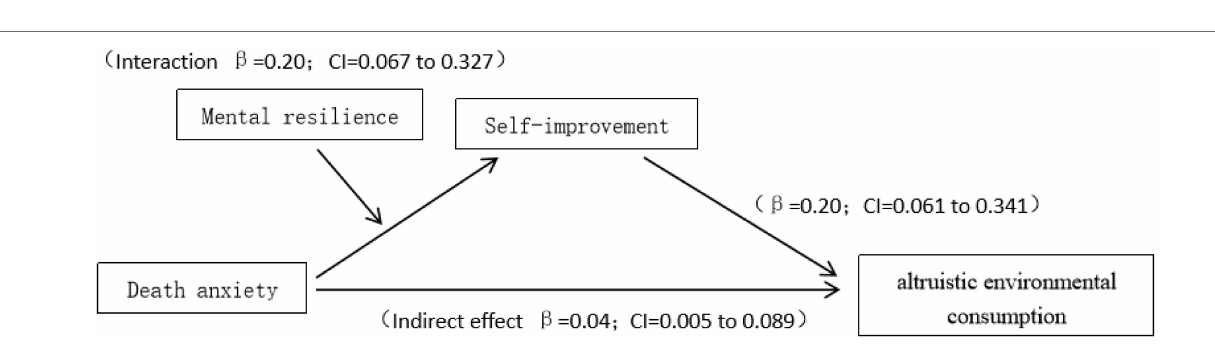
FIGURE 2 | The influence of the interaction between death anxiety and mental resilience on altruistic environmental